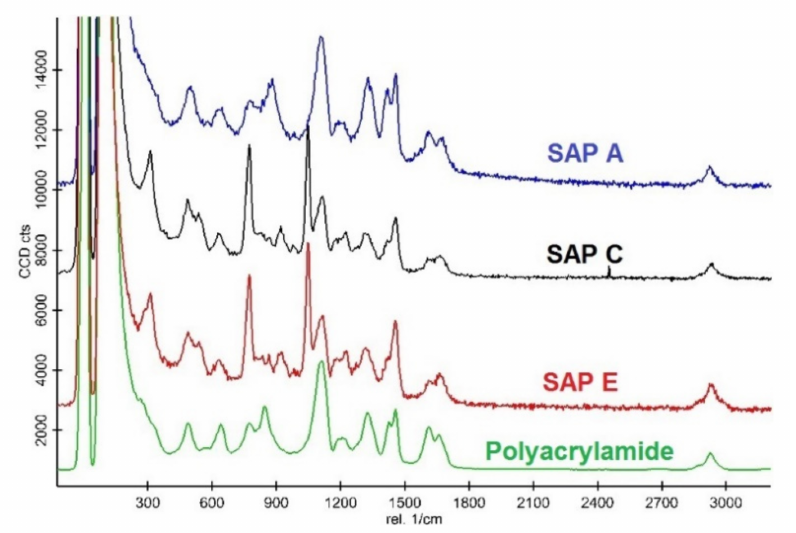
Figure 9. Molecular structure characterisation of SAP samples